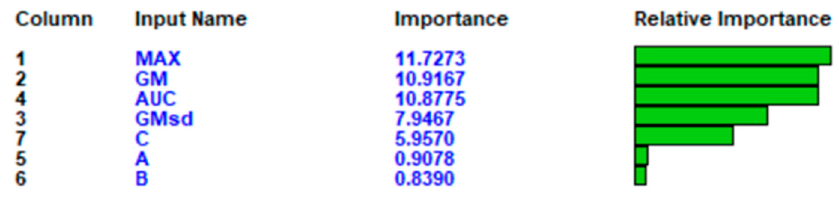
Figure 7. ANN learning cycle parameters.